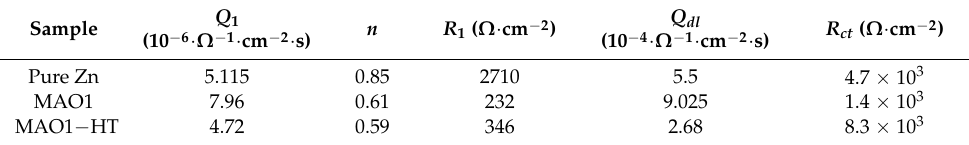
Table 3. The results of the impedance elements in the equivalent